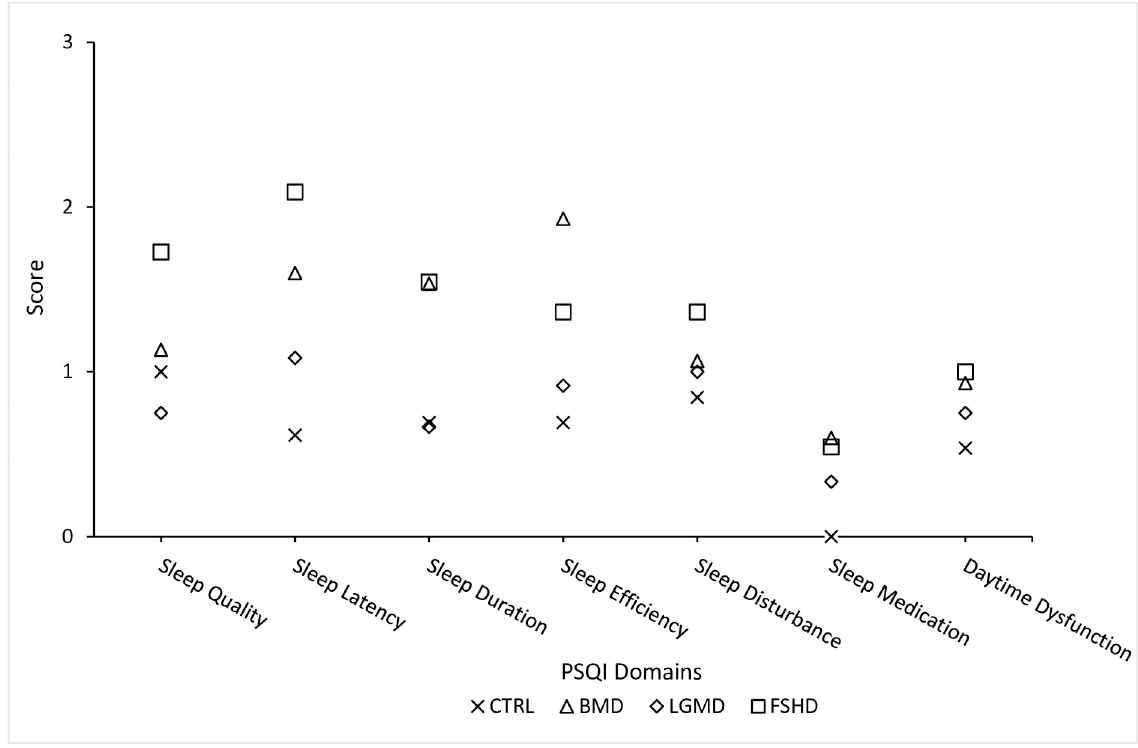
Fig 1. Group scores for PSQI domains. For clarity, differences between groups are described in text but not displayed on this Figure.